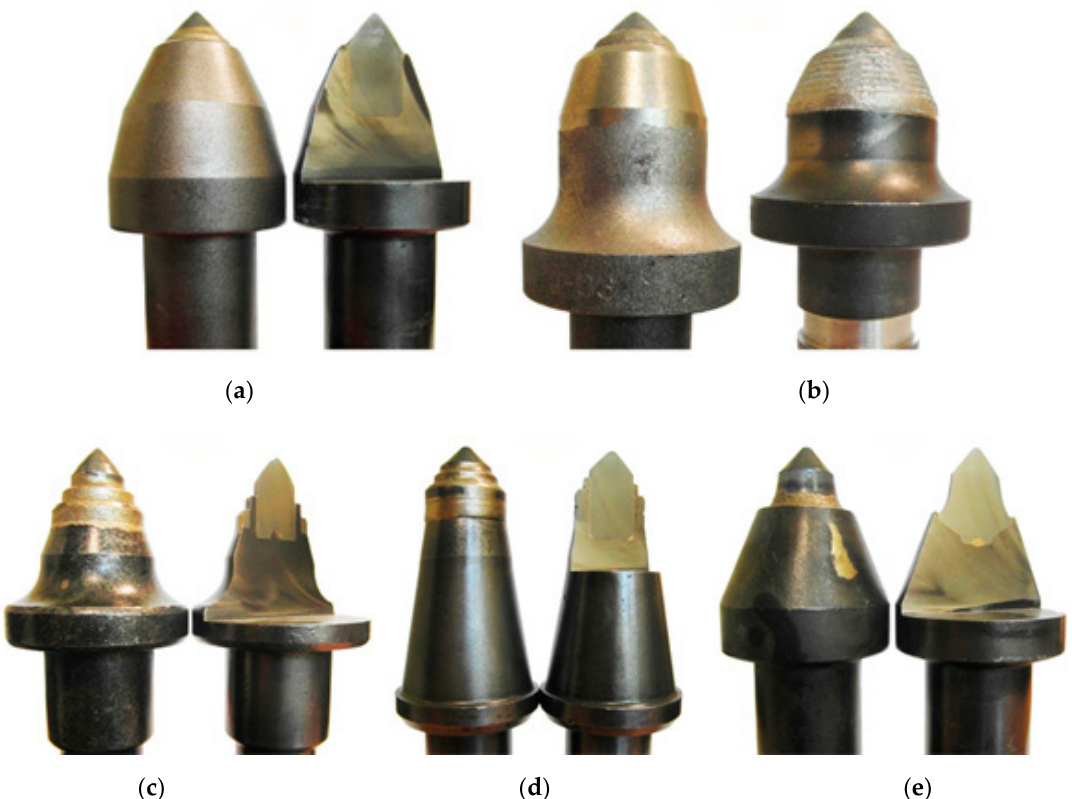
Figure 4. Options of additional protection of conical picks against abrasive wear: ( a ) standard pick; ( b ) welded picks; ( c ) pick with a ring made of WC-Co; ( d ) pick with two rings made of WC-Co; ( e ) pick with a lowered body and WC-Co insert in the CAP type [28].